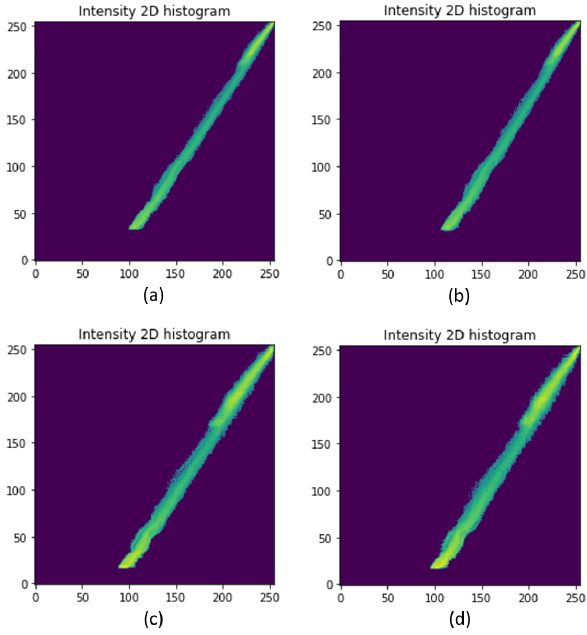
Figure 2. Histograms showing the link between pre-veil and veil pixel intensities (mean of fifty im- ages from the FRIDA dataset [16]). ( a ) homogeneous fog and illumination, ( b ) homogeneous fog and heterogeneous illumination, ( c ) heterogeneous fog and homogeneous illumination, ( d ) heterogeneous fog and illumination.